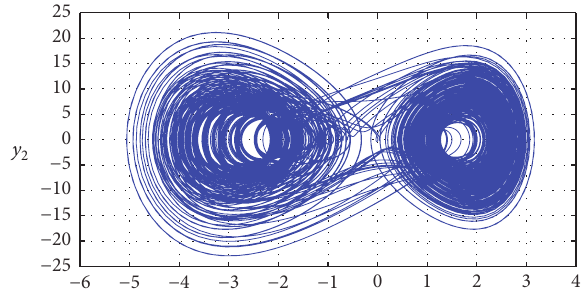
Figure 1: Chaotic motion of Mathieu-Van der pol system with uncertainties by 𝑦 1 - 𝑦 2